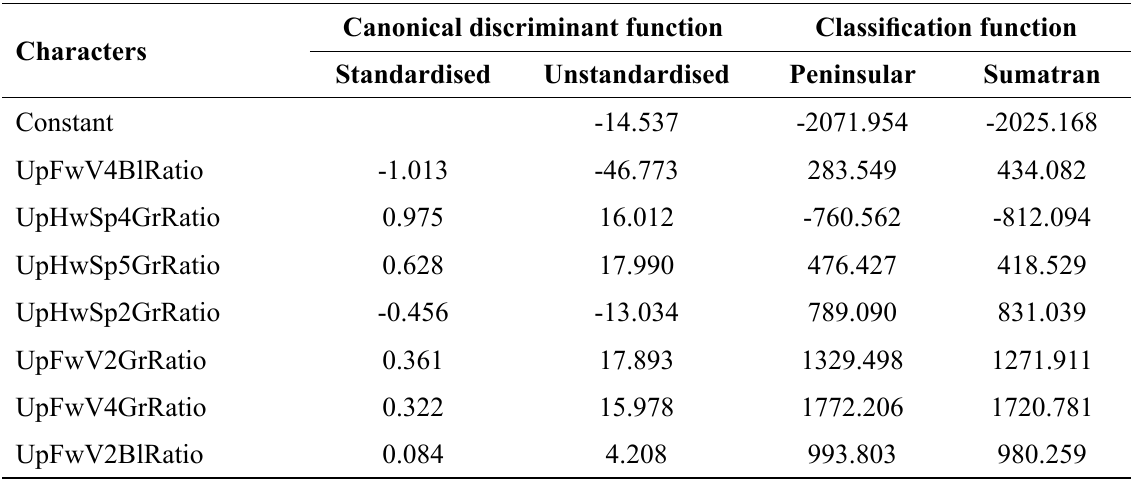
Table 6. Coefficients and constants for each ratio character in the cross-validated canonical discriminant and classification functions of male birdwings from Sumatra and Peninsular Malaysia.